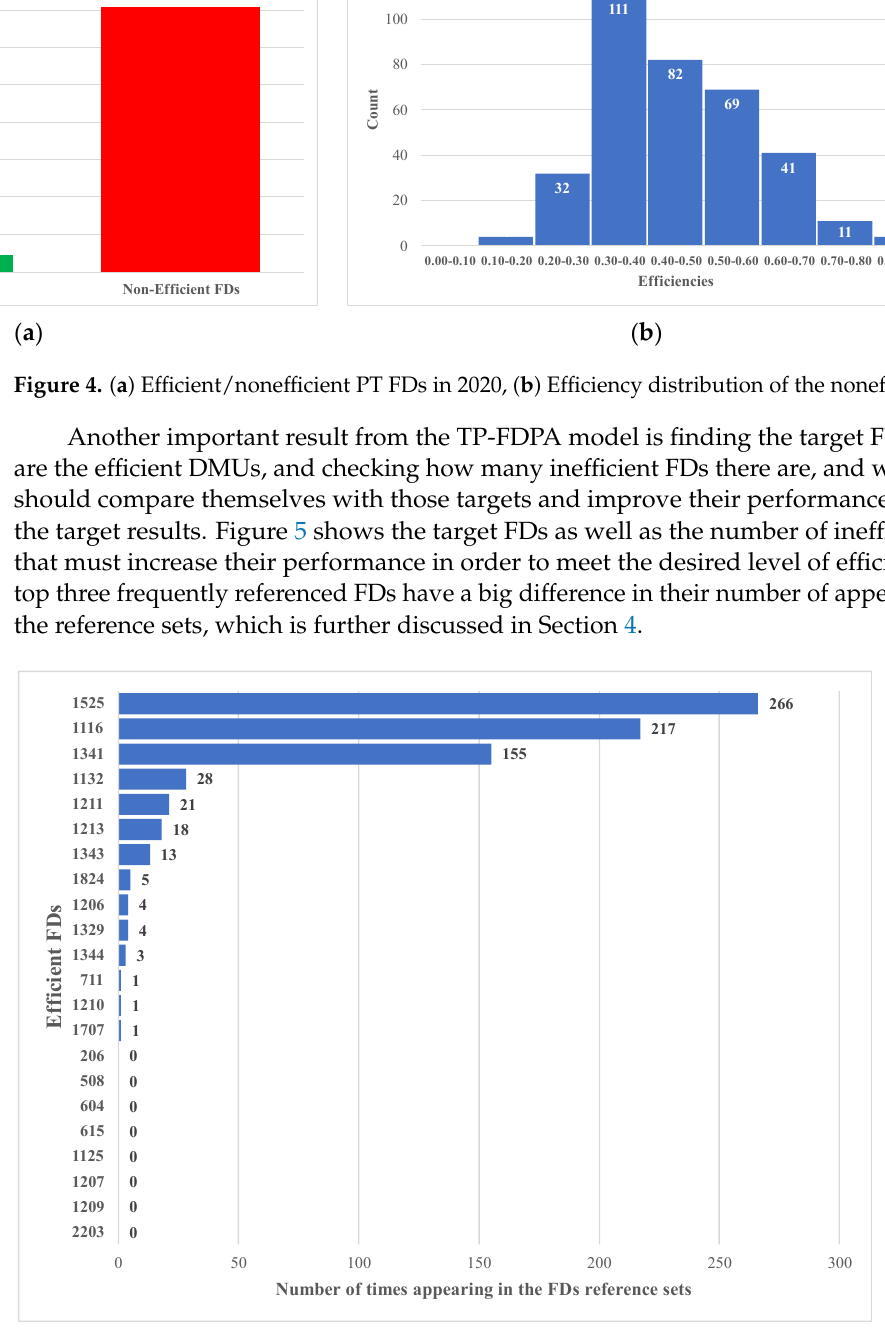
Figure 5. Efficient FDs and their number of appearances in the reference sets as targets for other FDs.